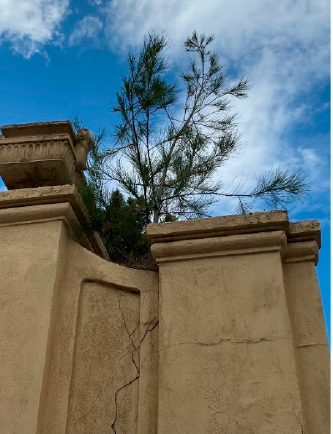
Figure A3. Cascabela thevetia (L.) Lippold found ( a ) in a water drainage channel in Melito di Porto Salvo (Reggio Calabria province) and ( b ) mixed with Phyllostachys aurea Carrière ex Rivière & C. Rivière in Reggio Calabria (Reggio Calabria province) (Photographs VLA Laface).